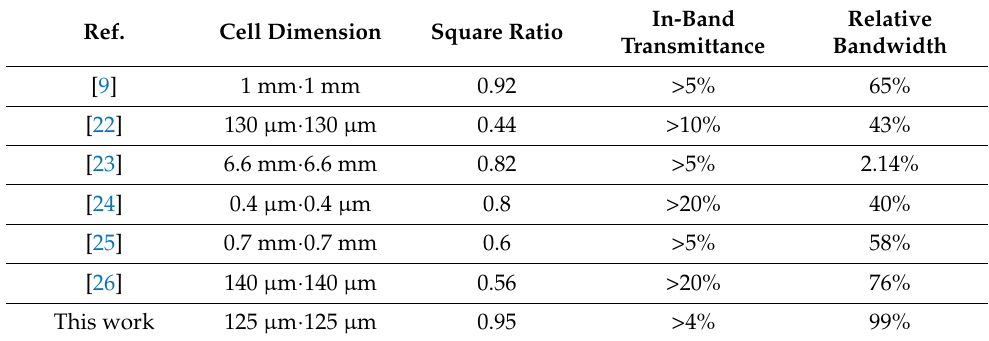
Table 1. Comparison of transmittance with other filters. Ref. Cell Dimension Square